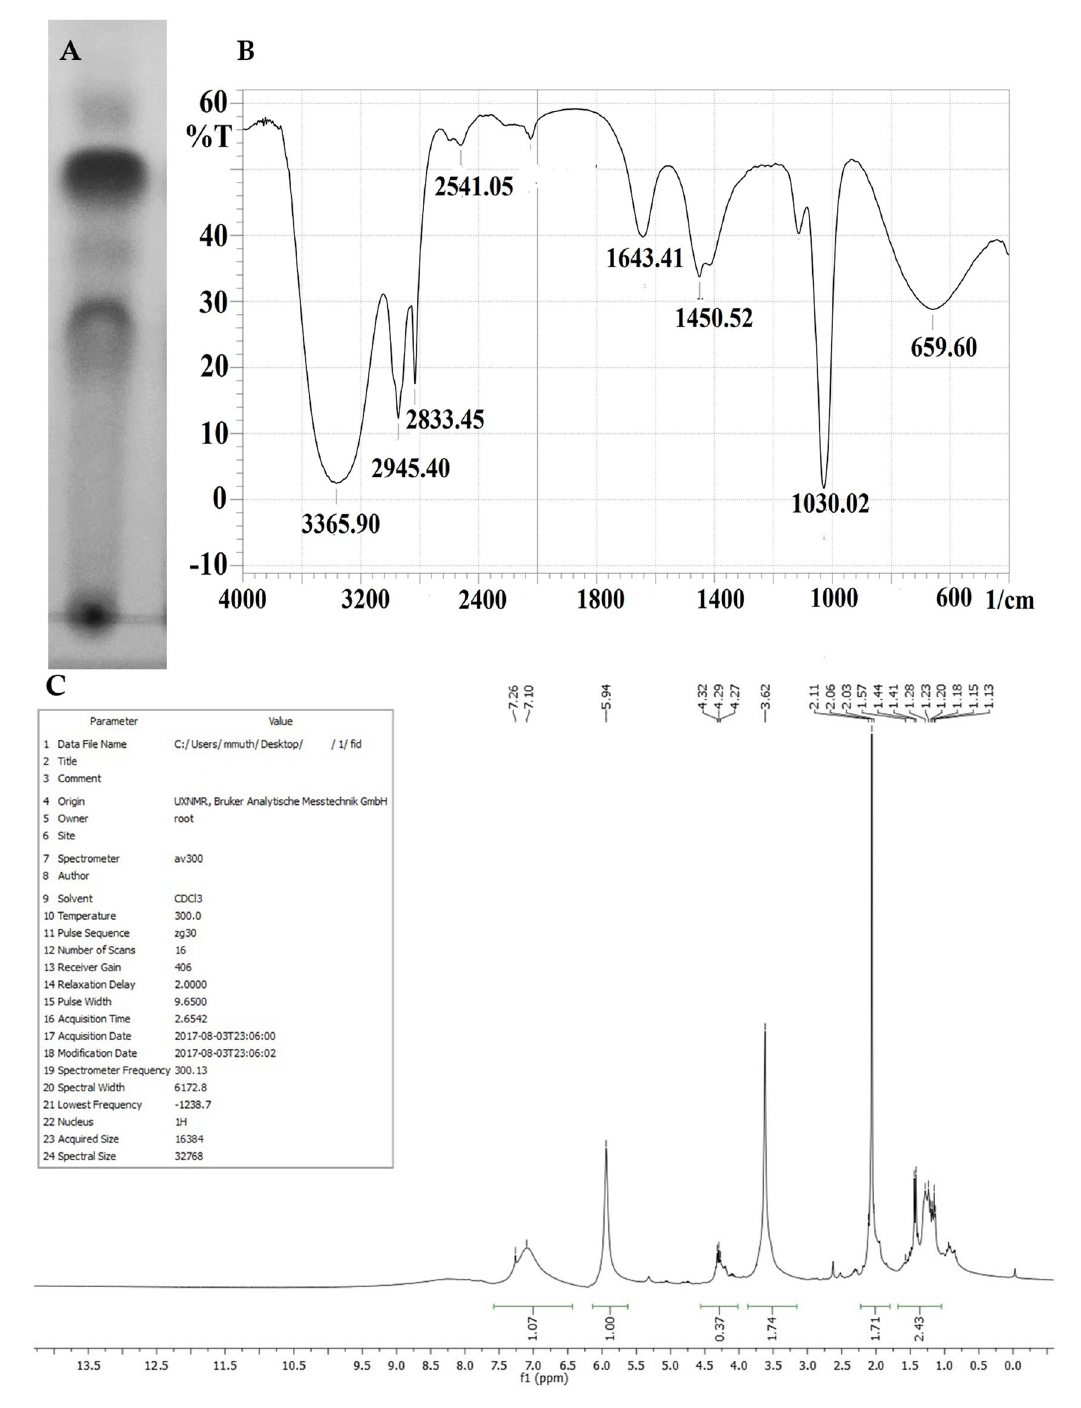
Figure 2. Biosurfactant characterization ( A ) TLC chromatogram of isolated biosurfactant, ( B ) FTIR spectrum of biosurfactant from Paenibacillus thiaminolyticus SK10. ( C ) 1H NMR spectrum for biosurfactant from Paenibacillus thiaminolyticus